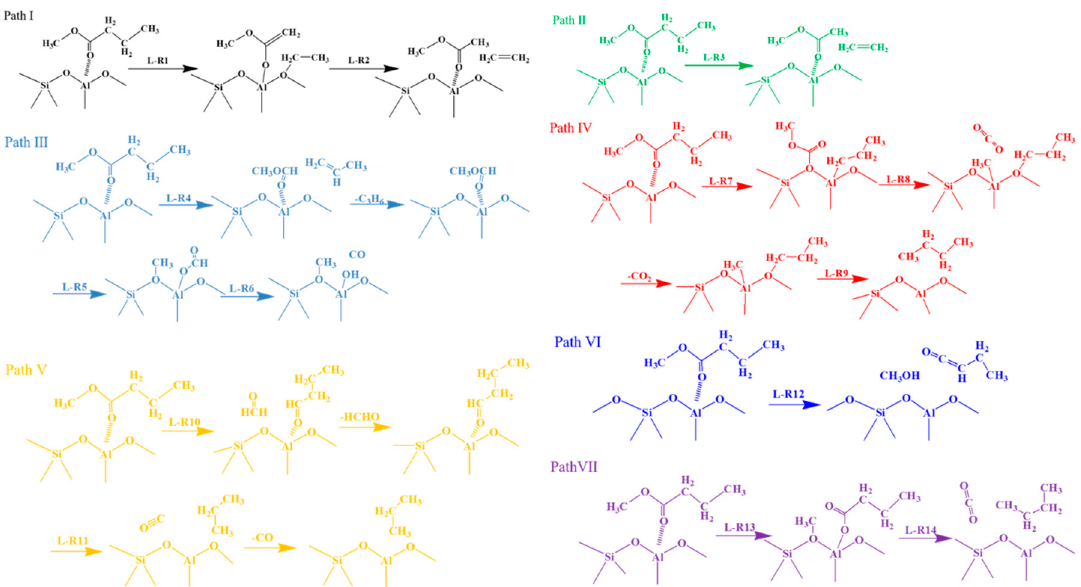
Figure 2. Deoxygenation reaction paths of MB on the Lewis acid of ZSM-5 zeolite. Catalysts 2020 , 10 , x FOR PEER REVIEW